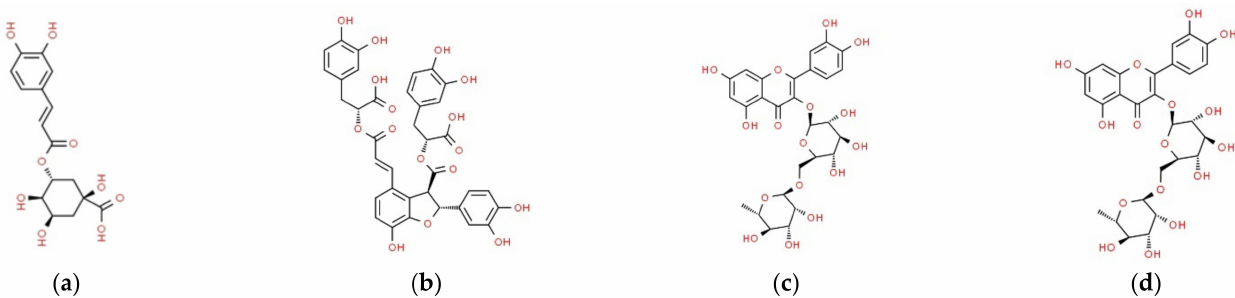
Figure 10. Fluorescence intensity ratio of CQDs with different reference substances added.